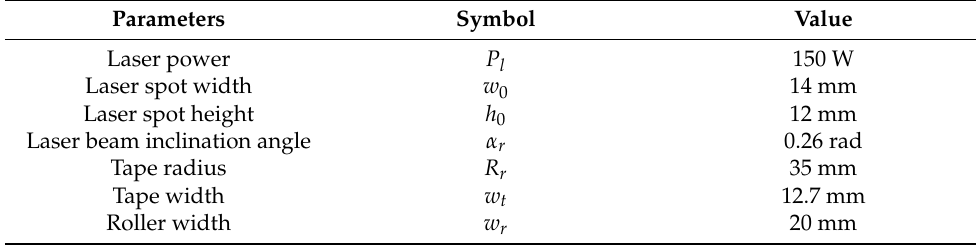
Figure 4. Laser irradiation model ( a ) and simplified 2D geometry for analytical model ( b ). Table 2. Geometric parameters.